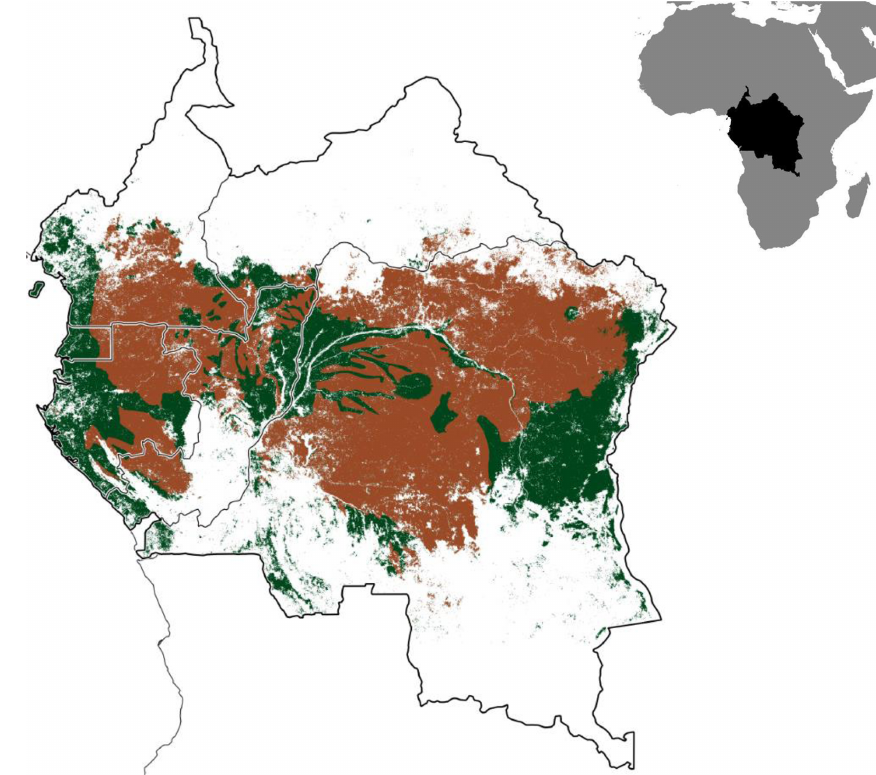
Figure B3. Map of the Congo Basin rainforest (green) spanning across the six major Congo Basin countries. The brown shaded area represents the proportion of the Congo rainforest with biophysical conditions similar to those in our study sites (Ferralsol soils, ≤ 1000m elevation and 1500–2100mmyr − 1